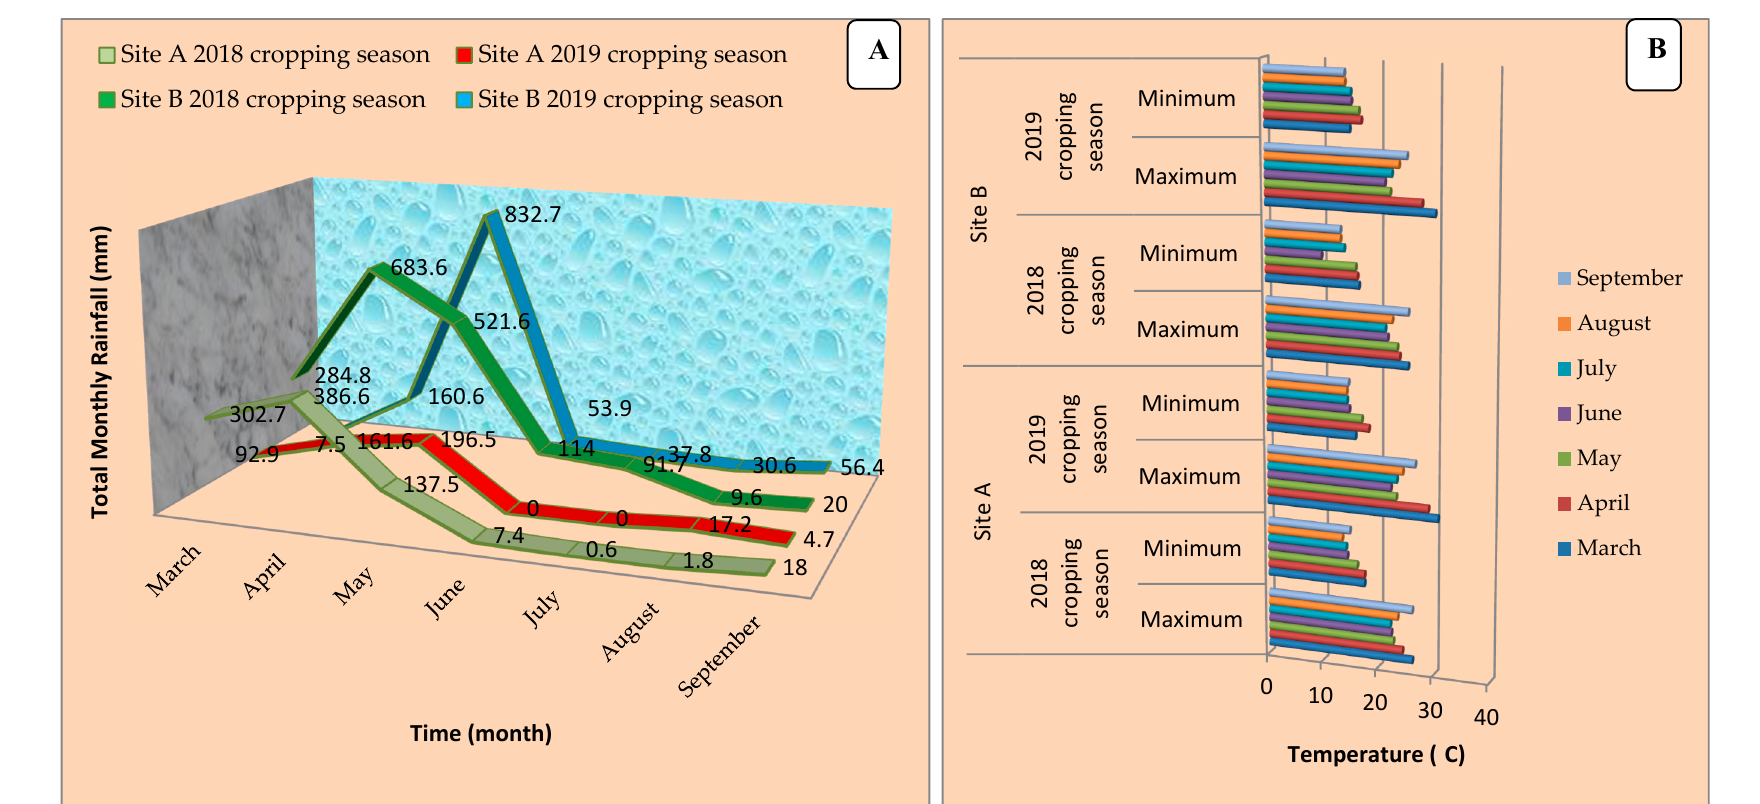
Figure 1. Meteorological characteristics of the two study sites. ( A ) rainfall dynamics of the study sites; ( B ) temperature dynamics of the study sites.